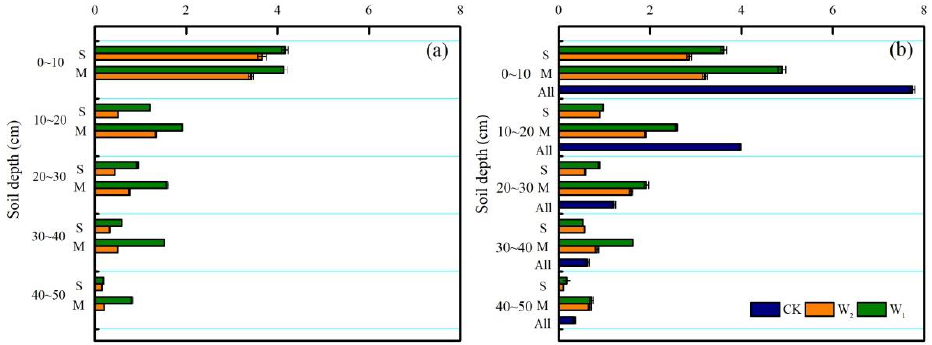
Figure 6. Distribution of the root dry weight in different soil layers at harvest under APRI ( a ) and CI ( b ).